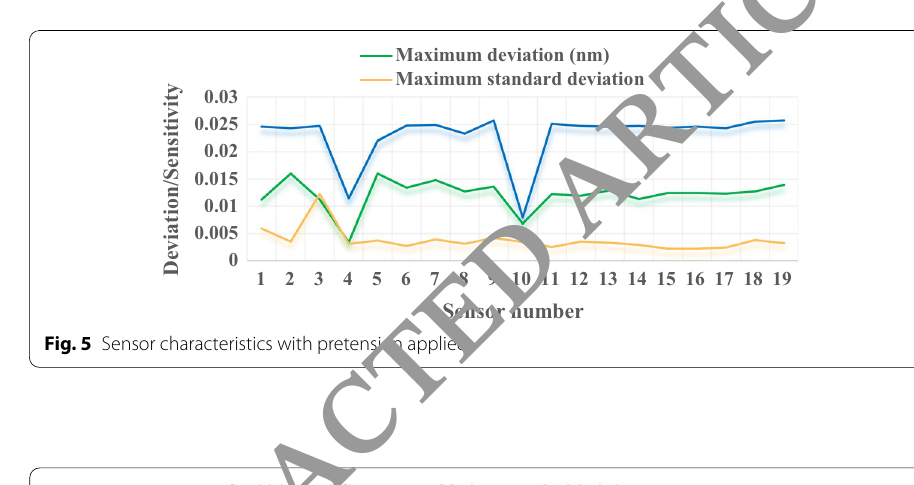
Category Center wavelength (before packaging) Center wavelength (after packaging)